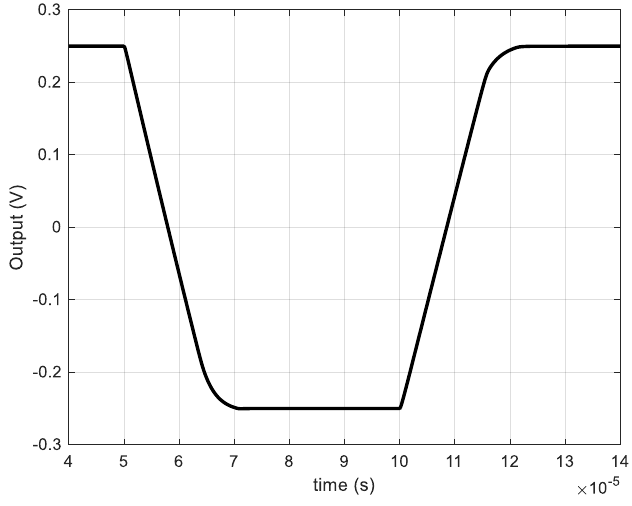
Figure 9. Pulse response of the amplifier.